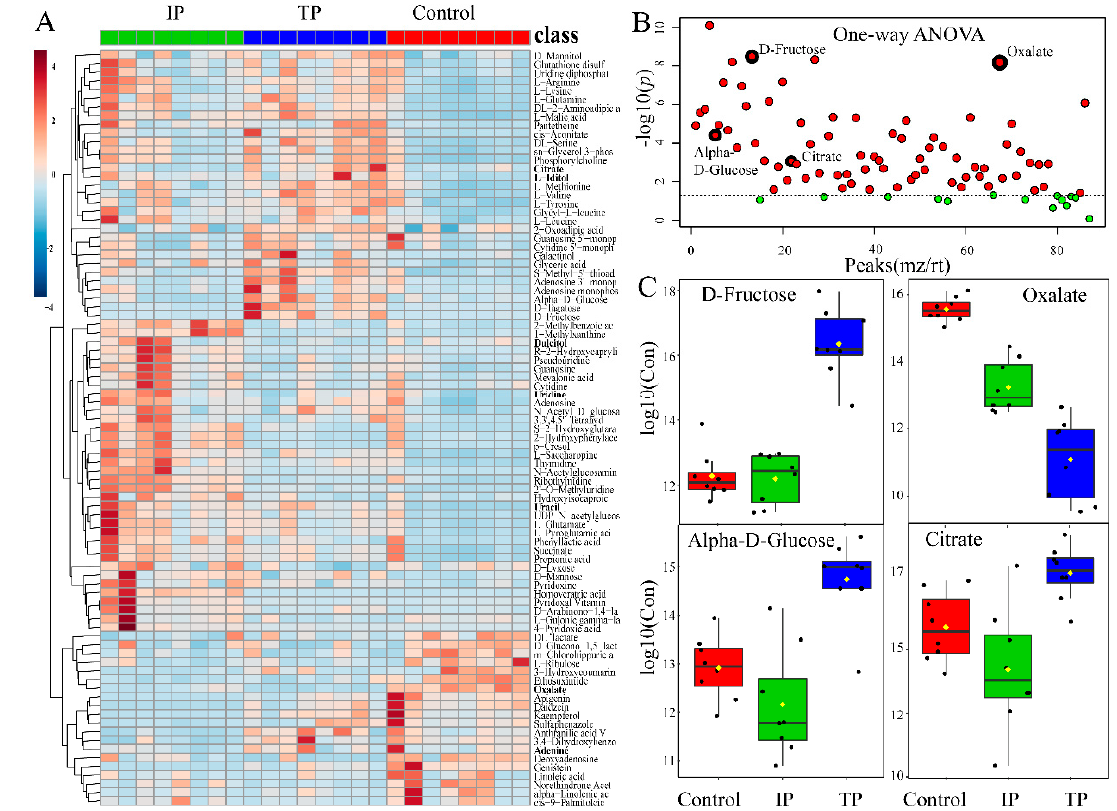
Figure 3. Metabolic analysis in P. oxalicum with tricalcium phosphate (TP), iron phosphate (IP), and dipotassium phosphate (C) exposure. ( A ) Heat map visualization, hierarchical clustering analysis (HCA) provided intuitive visualization of all 73 identified metabolites with generalized logarithm transformation of concentration. Relative metabolite levels of three treatments were performed using an average clustering algorithm and Pearson’s correlation distance measure. ( B ) Important features selected by one-way ANOVA and Tukey’s HSD with p -value threshold 0.05 (Table S1). Data represent − log 10 (raw p -value) changes. The dotted line represents the threshold p = 0.05. ( C ) Boxplot of 4 selected metabolomics features from the one-way ANOVA. The black dots represent the − log 10 (raw concentrations) from all the eight samples, and the notch indicates the 95% confidence interval around the median of each treatment. The mean concentration of each treatment is indicated with a yellow diamond.